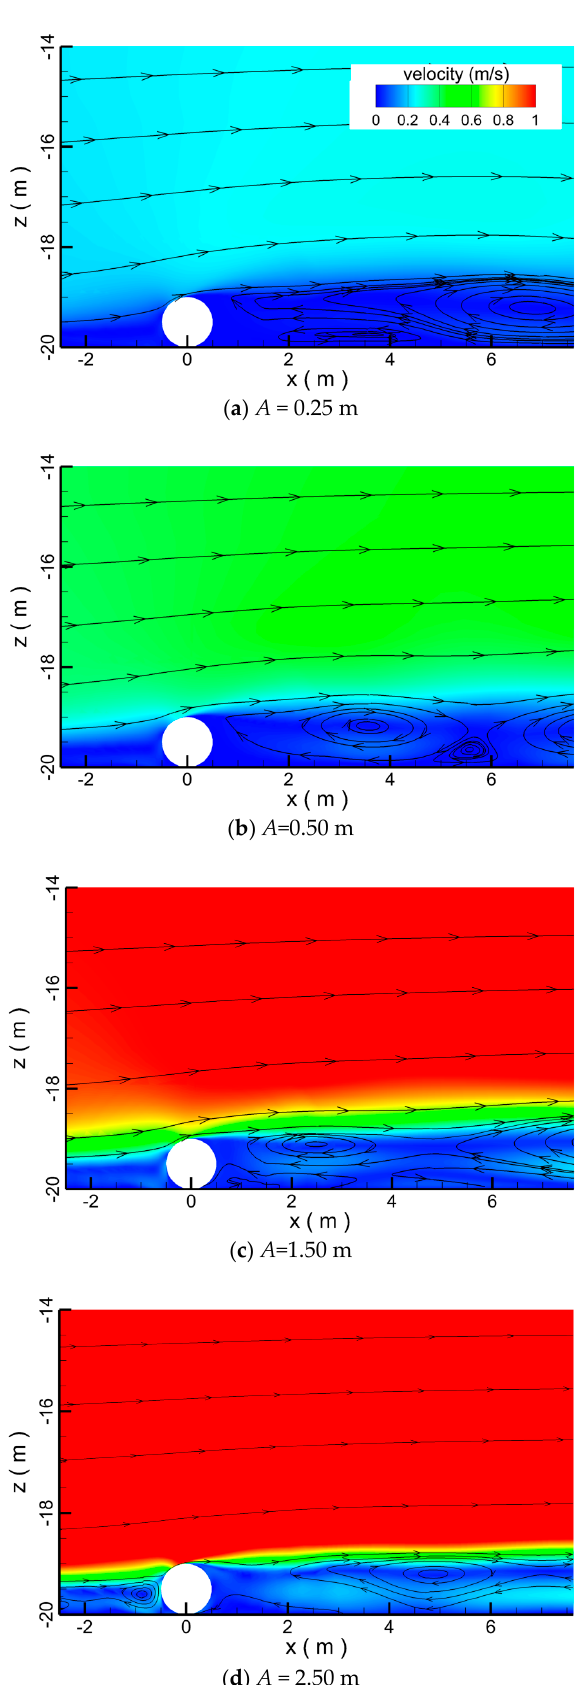
Figure 16. The flow fields around the pipeline under different tidal amplitudes in the time of t = 39 h.